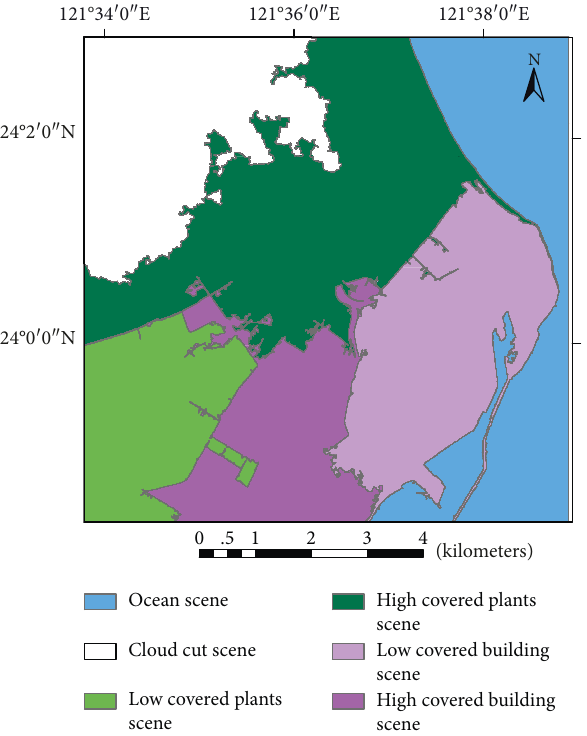
Table 4: Test sample statistics of image